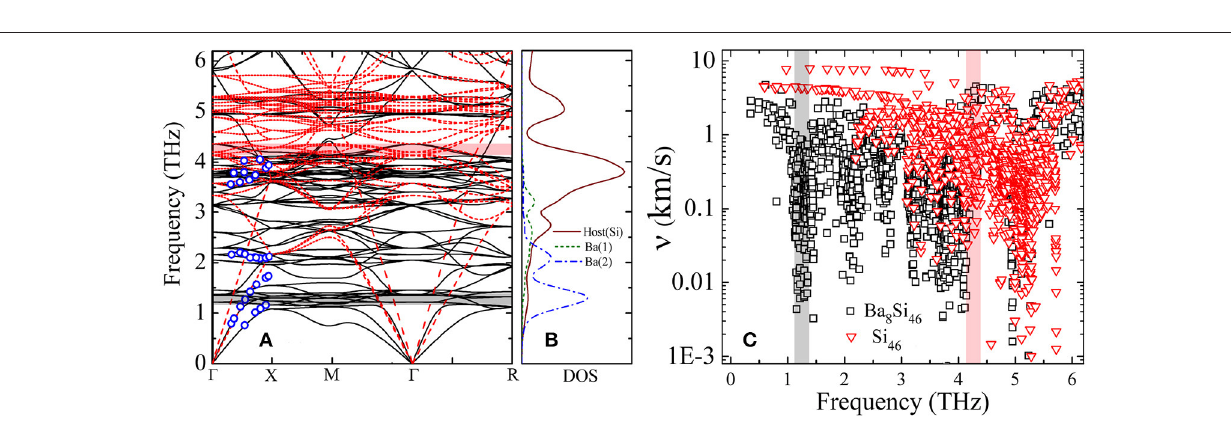
FIGURE 2 | Phonon dispersion and group velocity for Ba 8 Si 46 and Si 46 , respectively. (A) Calculation results of phonon dispersion for Ba 8 Si 46 (solid line) and Si 46 (dashed line). The experimental phonon dispersion data for Ba 8 Si 46 (circle) from literature (Pailhès et al., 2014) is also displayed for comparison. (B) Density of states (DOS) of host Si, Ba(1), and Ba(2) atoms in Ba 8 Si 46 , respectively. (C) Group velocity of Ba 8 Si 46 and Si 46 , respectively. The shadowed regions in (A,C) highlight the upper bound of acoustic branches for Ba 8 Si 46 (black) and Si 46 (red),